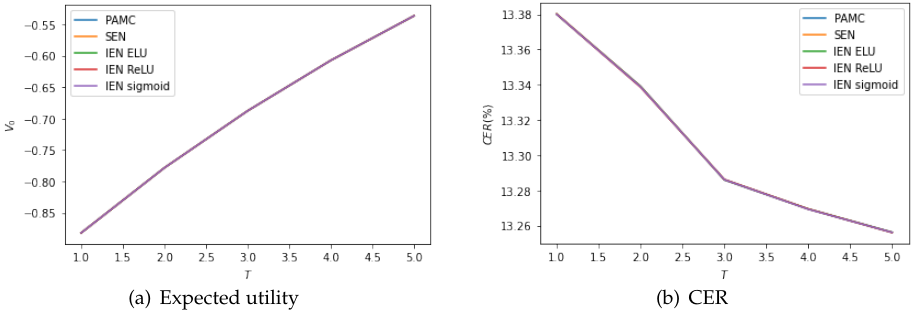
√ ) , where ( a ) shows the X t + b √ X t